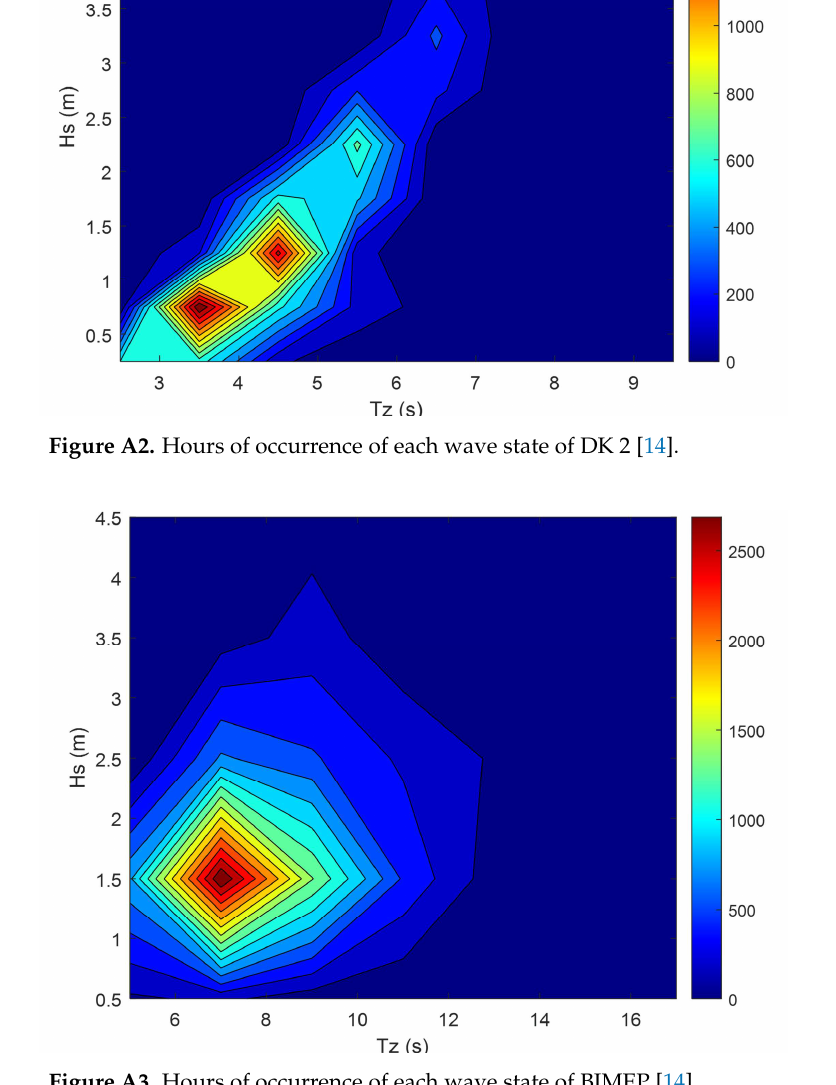
Figure A3. Hours of occurrence of each wave state of BIMEP